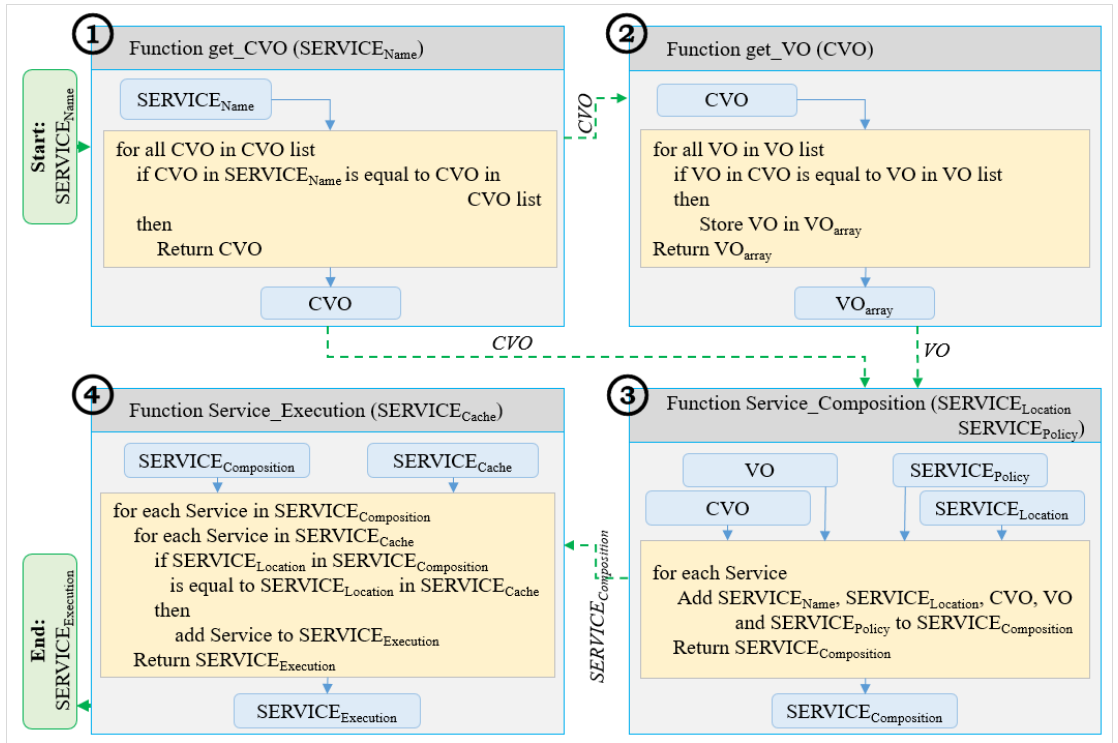
Figure 11. Context-matching algorithm based on location context